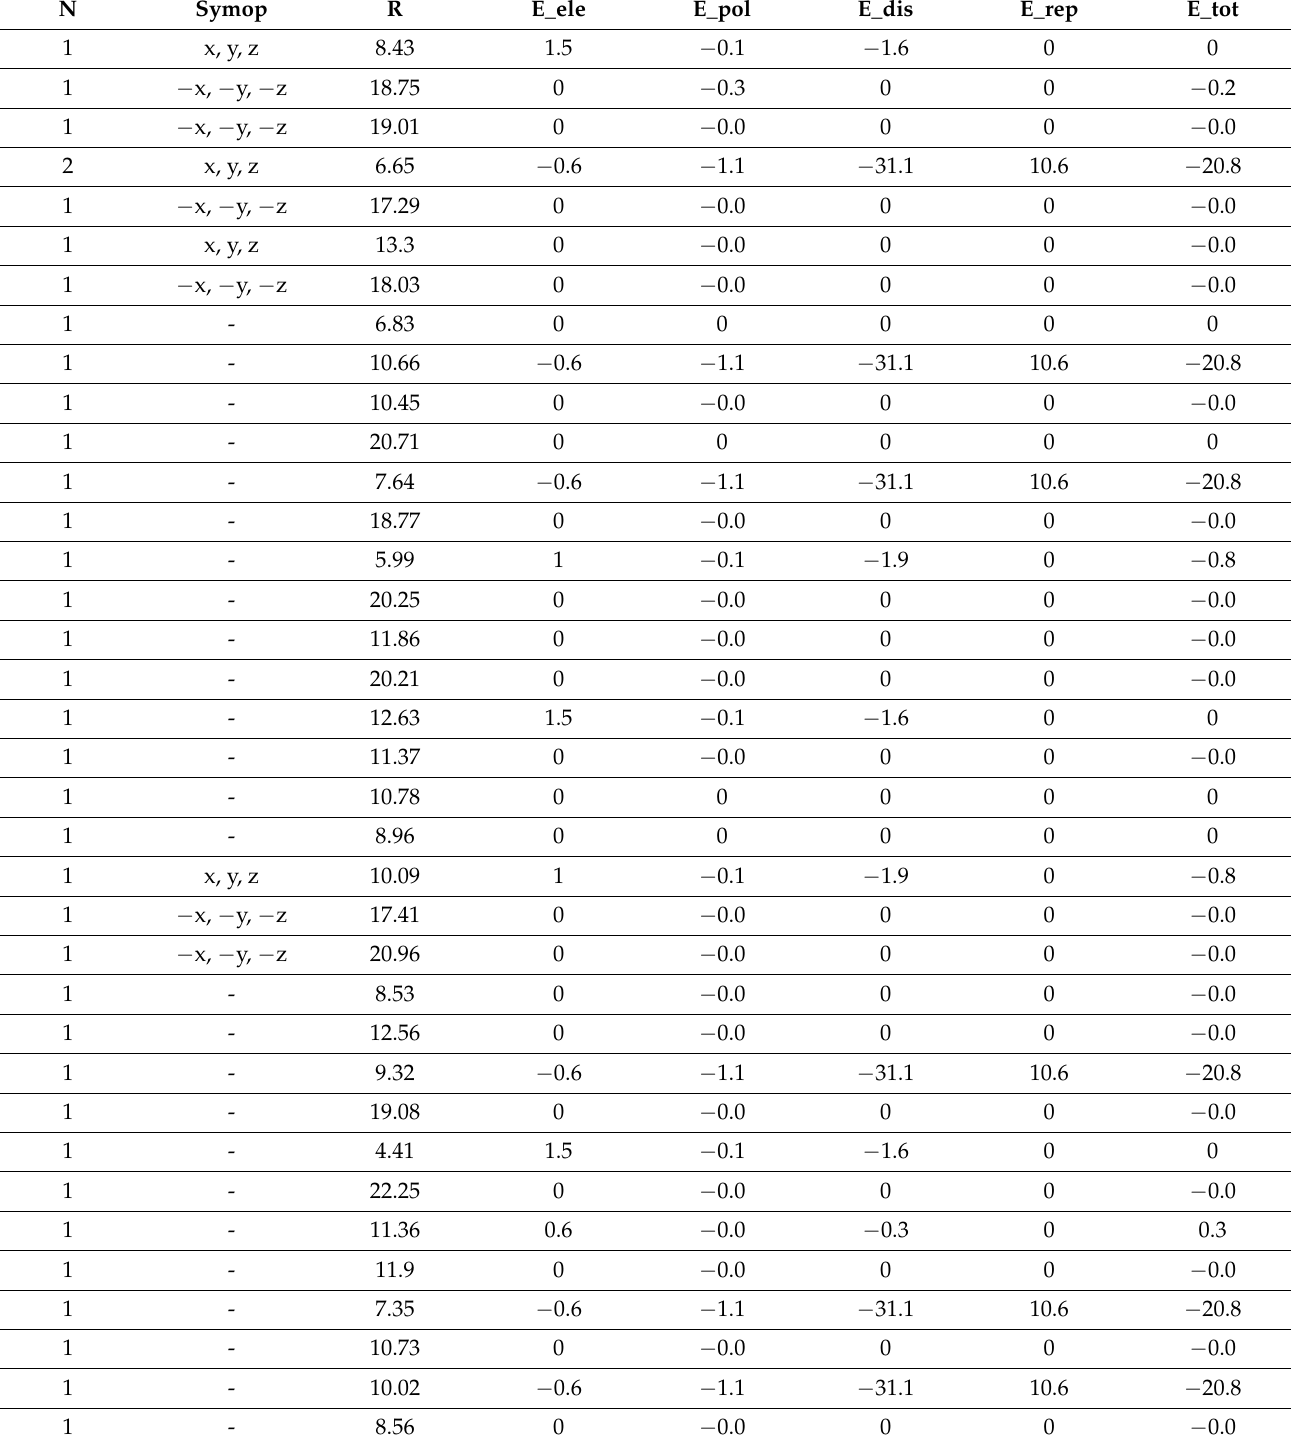
Table 6. Interaction energies of the 3C16 molecular pairs involved in energy calculation in kJ/mol. R is the distance between molecular centroids in Å, and N is the number of molecular pairs